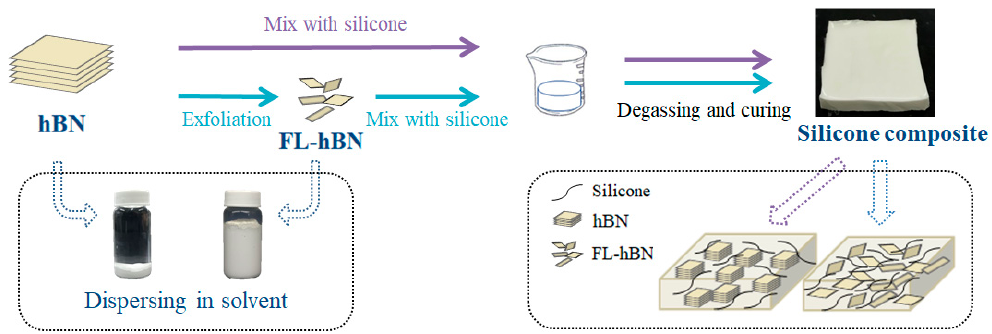
Figure 1. Schematic diagram of the preparation of hexagonal boron nitride (h-BN) / silicone and few-layered hexagonal boron nitride (FL-hBN) / silicone composites by our approach.